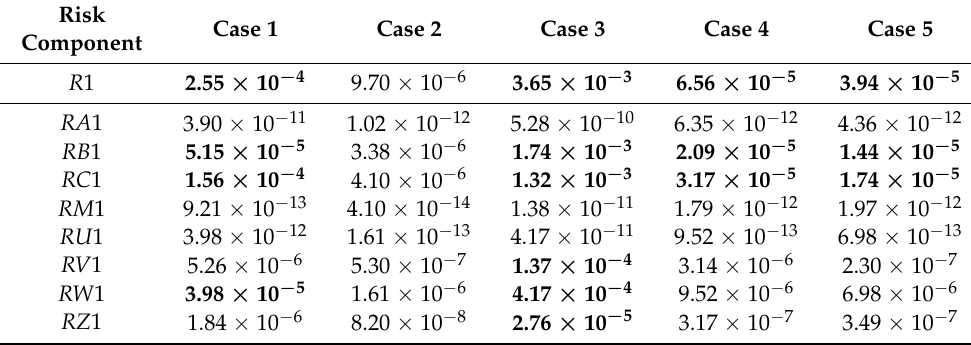
Table 21. Result of Risk Value of Loss of Human Life ( R 1) -Worse-case.